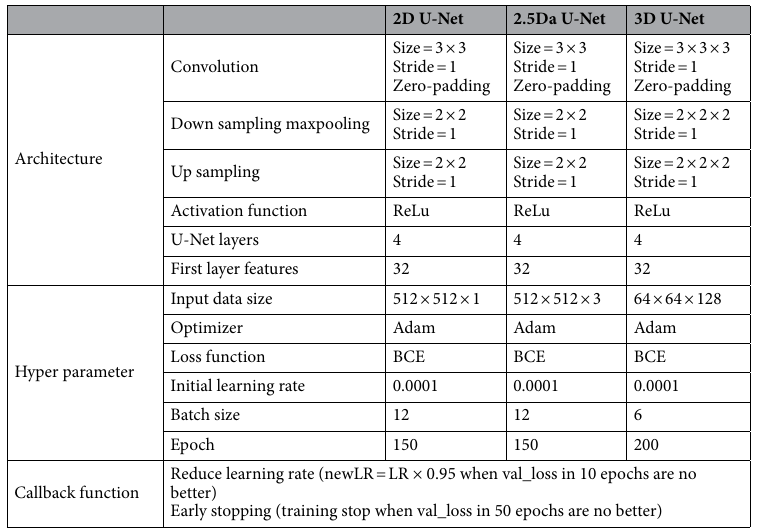
Table 1. Architectures and hyperparameters of 2D U-Net, 2.5Da U-Net, and 3D U-Net structures. Adam adaptive moment estimation, BCE binary cross entropy, ReLU rectified linear